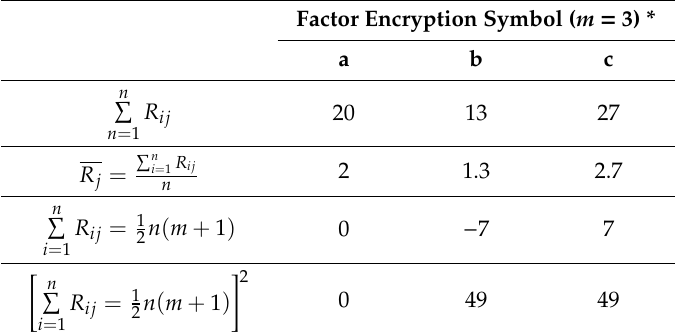
Table 5. Table illustrating the ranks of the received